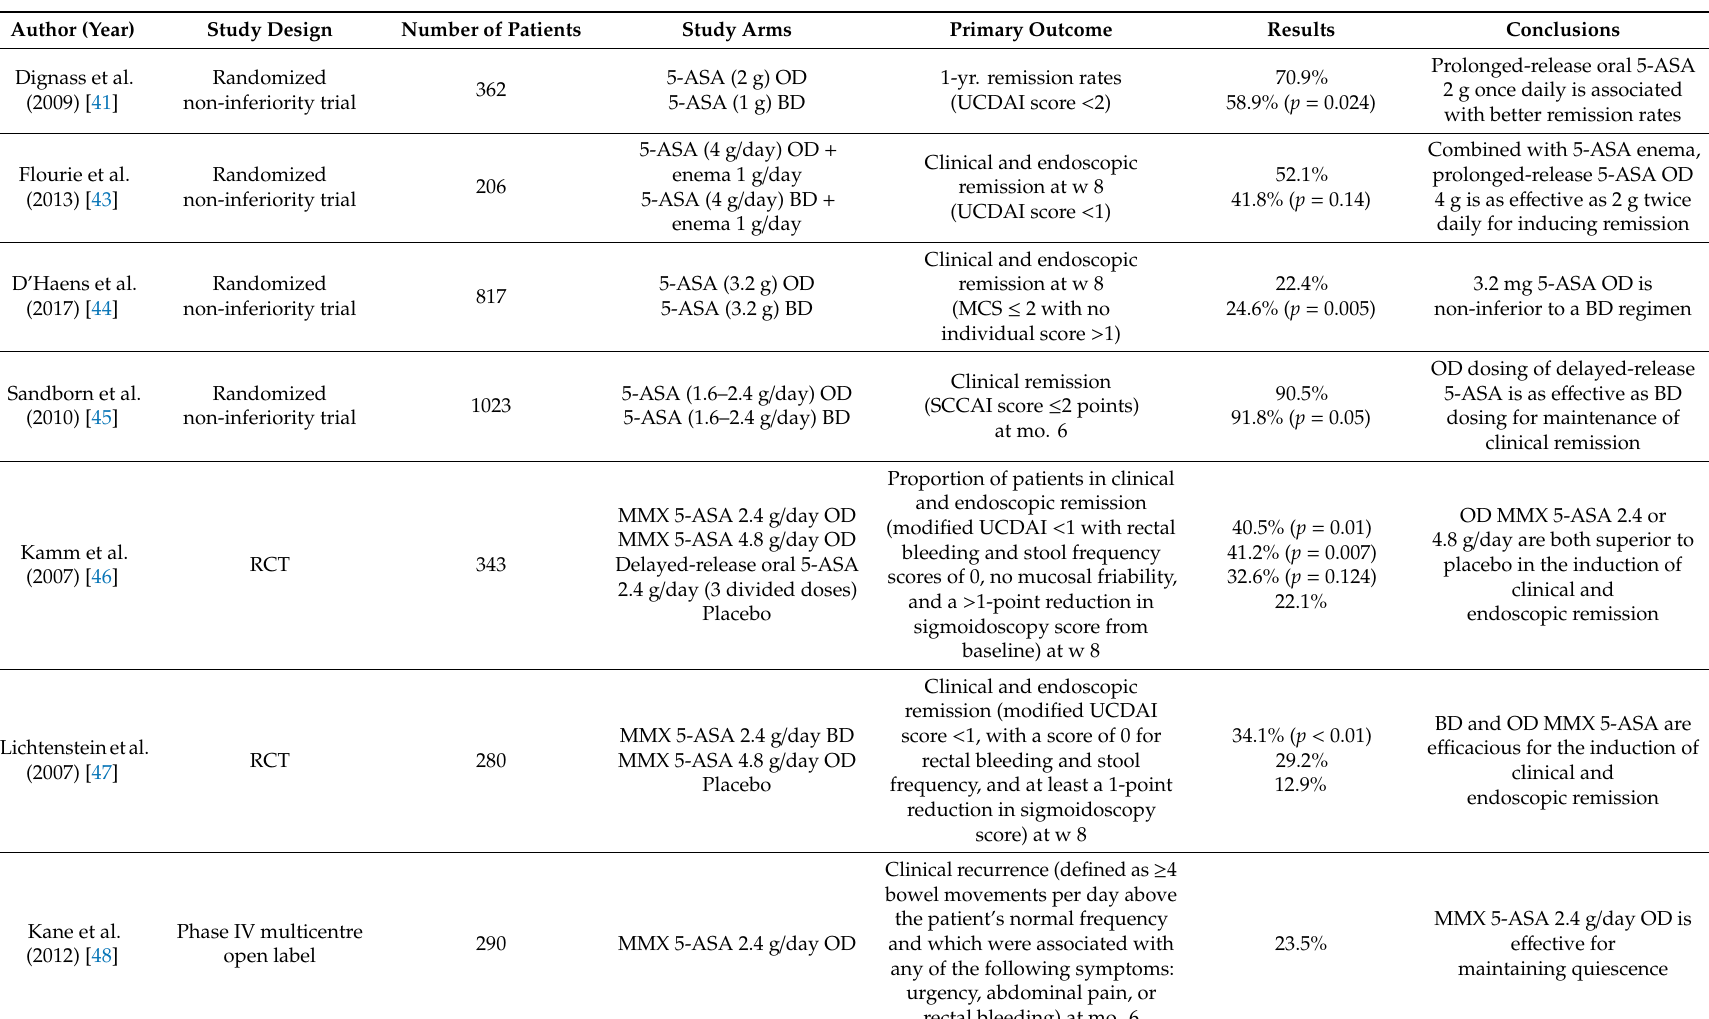
Table 1. Studies reporting the e ffi cacy of di ff erent doses and formulations of mesalamine in patients with mild-to-moderate ulcerative